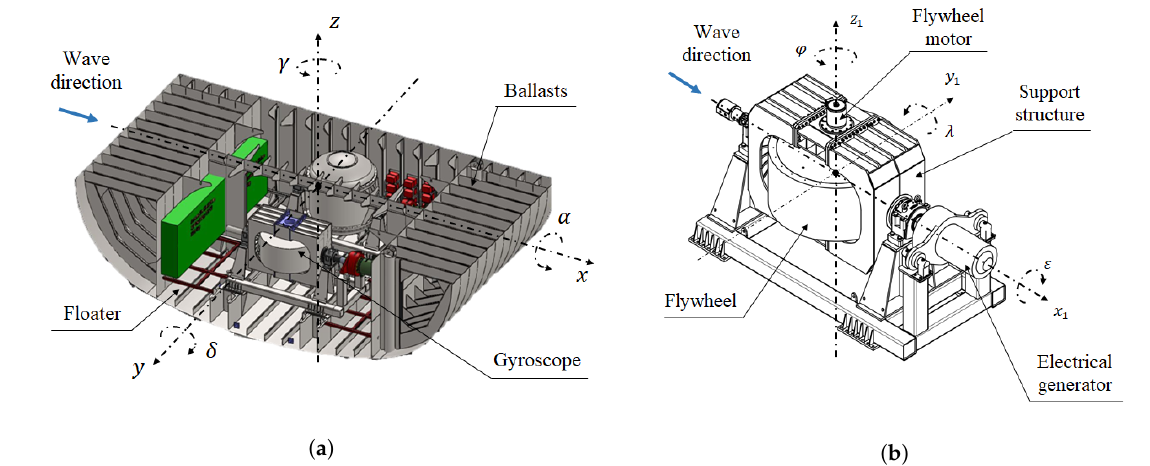
Figure 2. ISWEC device: architectures. ( a ) ISWEC hull; ( b ) ISWEC